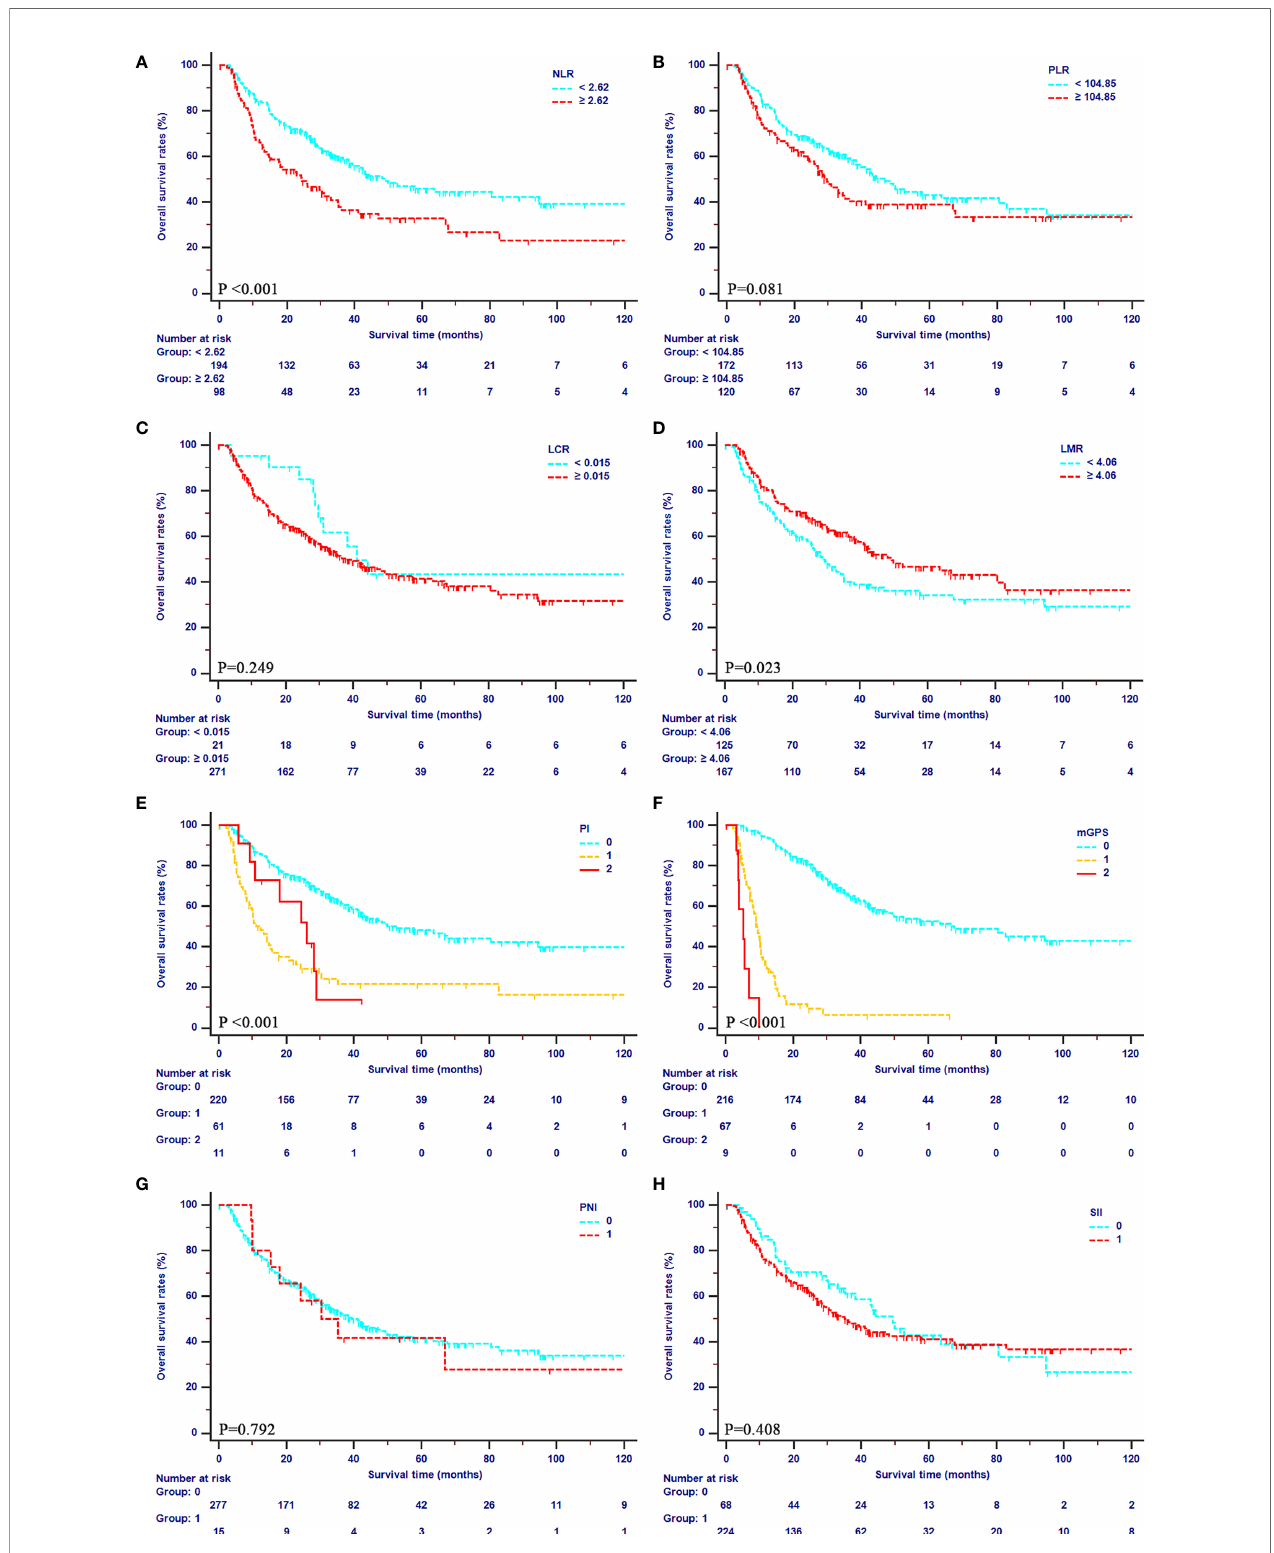
FIGURE 2 | Kaplan-Meier curves for OS in patients with iCCA in the SYSUCC cohort strati fi ed by the in fl ammation-based score systems. (A) , NLR; (B) , PLR; (C) , LCR; (D) , LMR; (E) , PI; (F) , mGPS; (G) , PNI; (H) ,